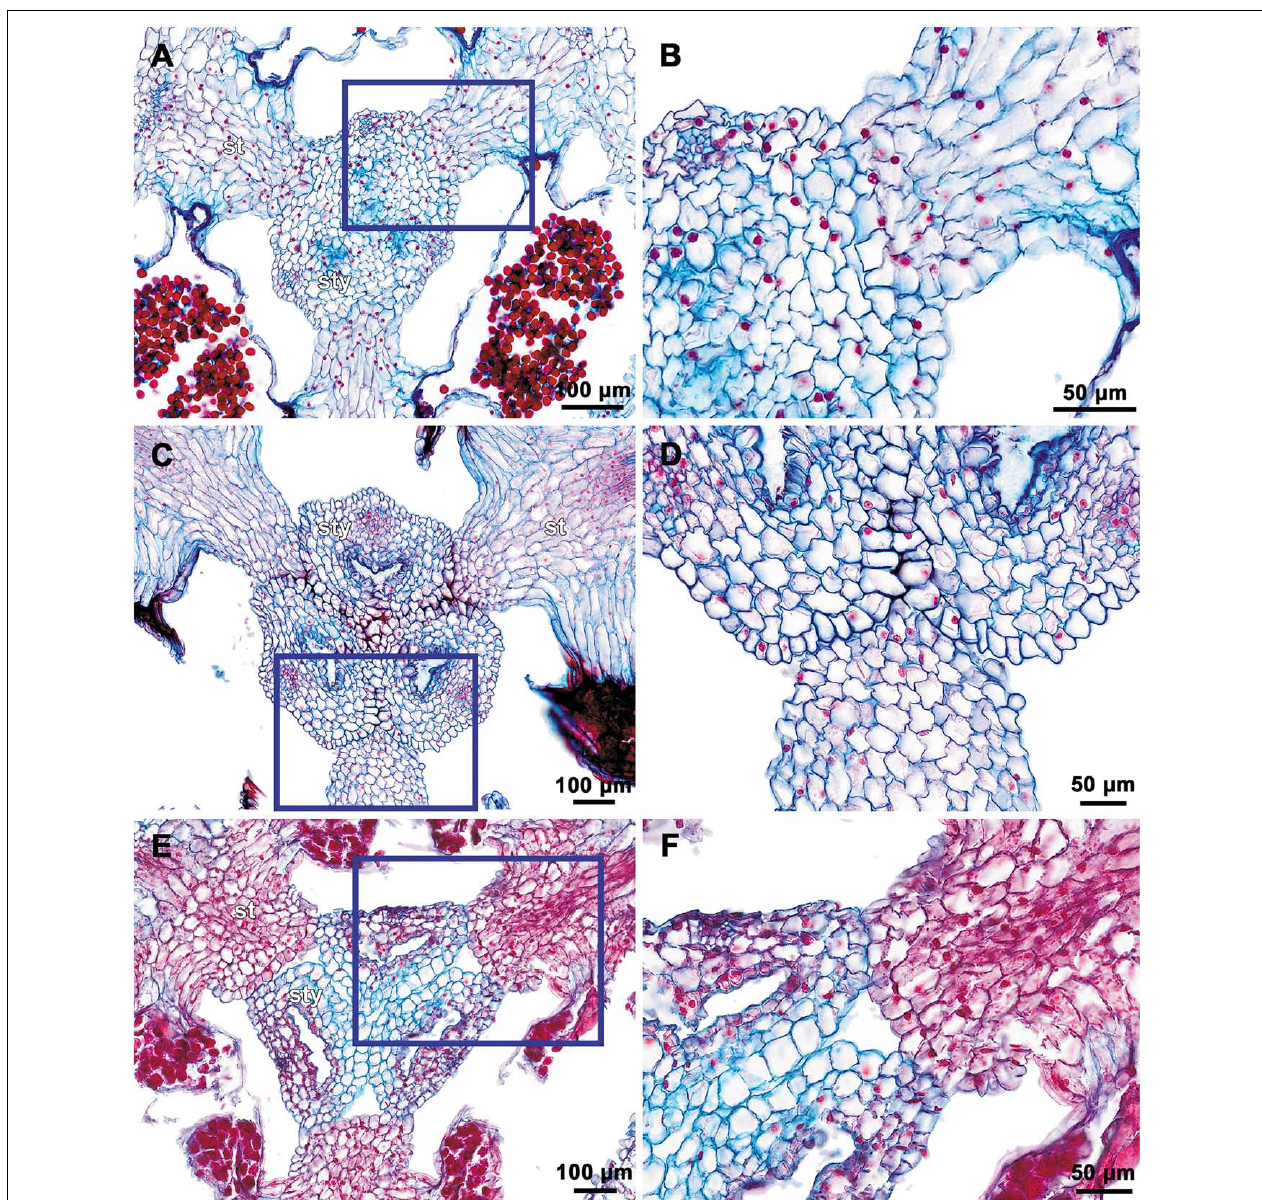
FIGURE 7 | Transverse microtome sections of flower buds of Burmannia (LM) showing interactions between stamens and common style. (A,B) B. oblonga ( Poyarkov s.n. ), gynostegium with undetectable boundaries of fused stamens and common style (and epidermal cells along the line of fusion). (C,D) B. itoana , gynostegium with recognizable boundaries of fused stamens and common style (epidermal cells differ from surrounding cells). (E,F) B. coelestis ( Nuraliev et al. 2736 ), stamens connivent with common style without fusion; central part of connective separated from common style by a gap. (B,D,F) Portions of sections contoured with blue in (A,C,E) respectively. st, stamen; sty,